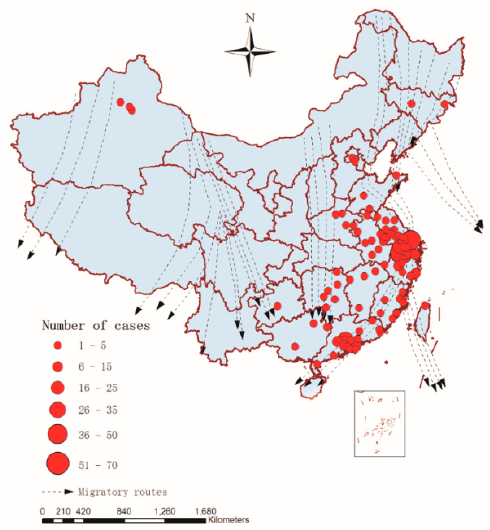
Figure 5. Migratory routes and spatial distribution of human cases of influenza A(H7N9) virus infection ( n = 460) in 18 provinces and municipalities, China, March 2013–December 2014.